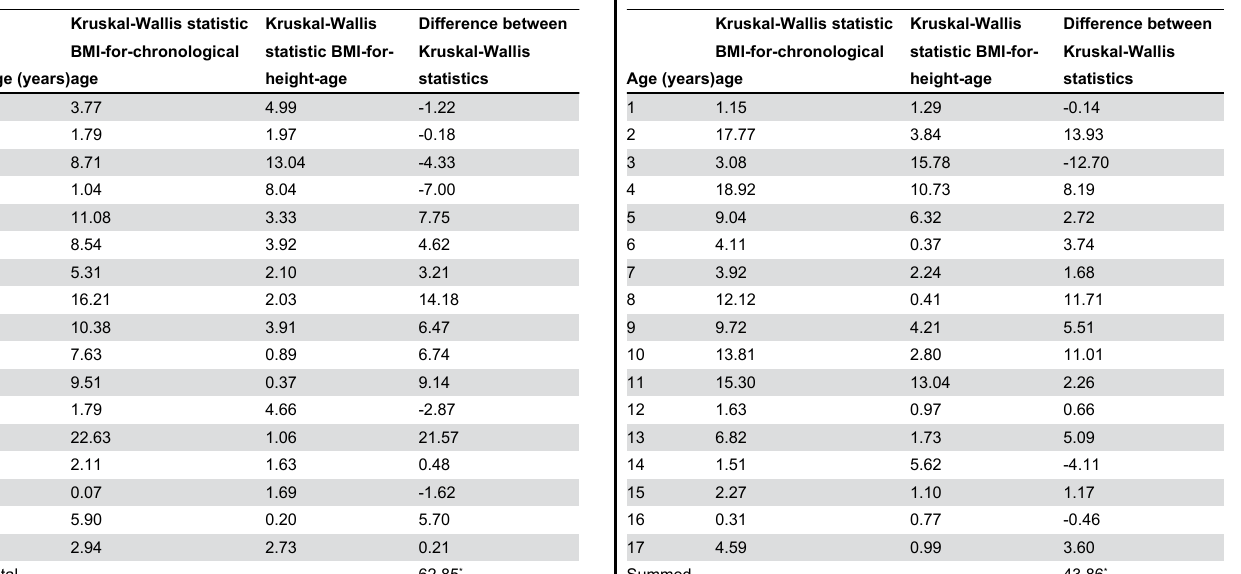
Table 2. Differences in Kruskal-Wallis statistics to identify intergroup differences between the samples for BMI according to chronological age and BMI according to height-age in boys.